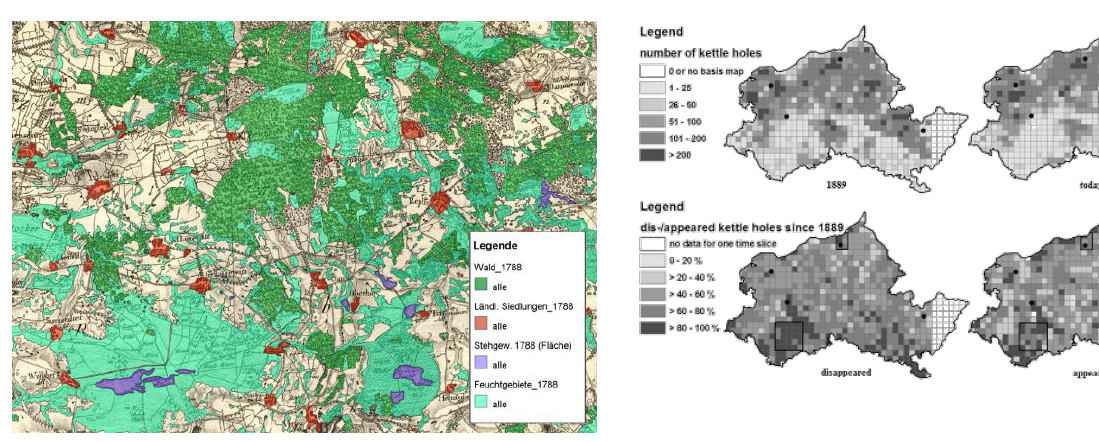
Figure 8. Number of kettle-holes and their dynamics since 1889 until today.